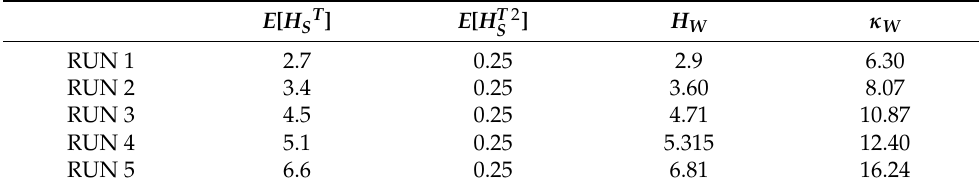
Table 2. List of values of two parameters of Weibull distribution suggested by PIANC [18].